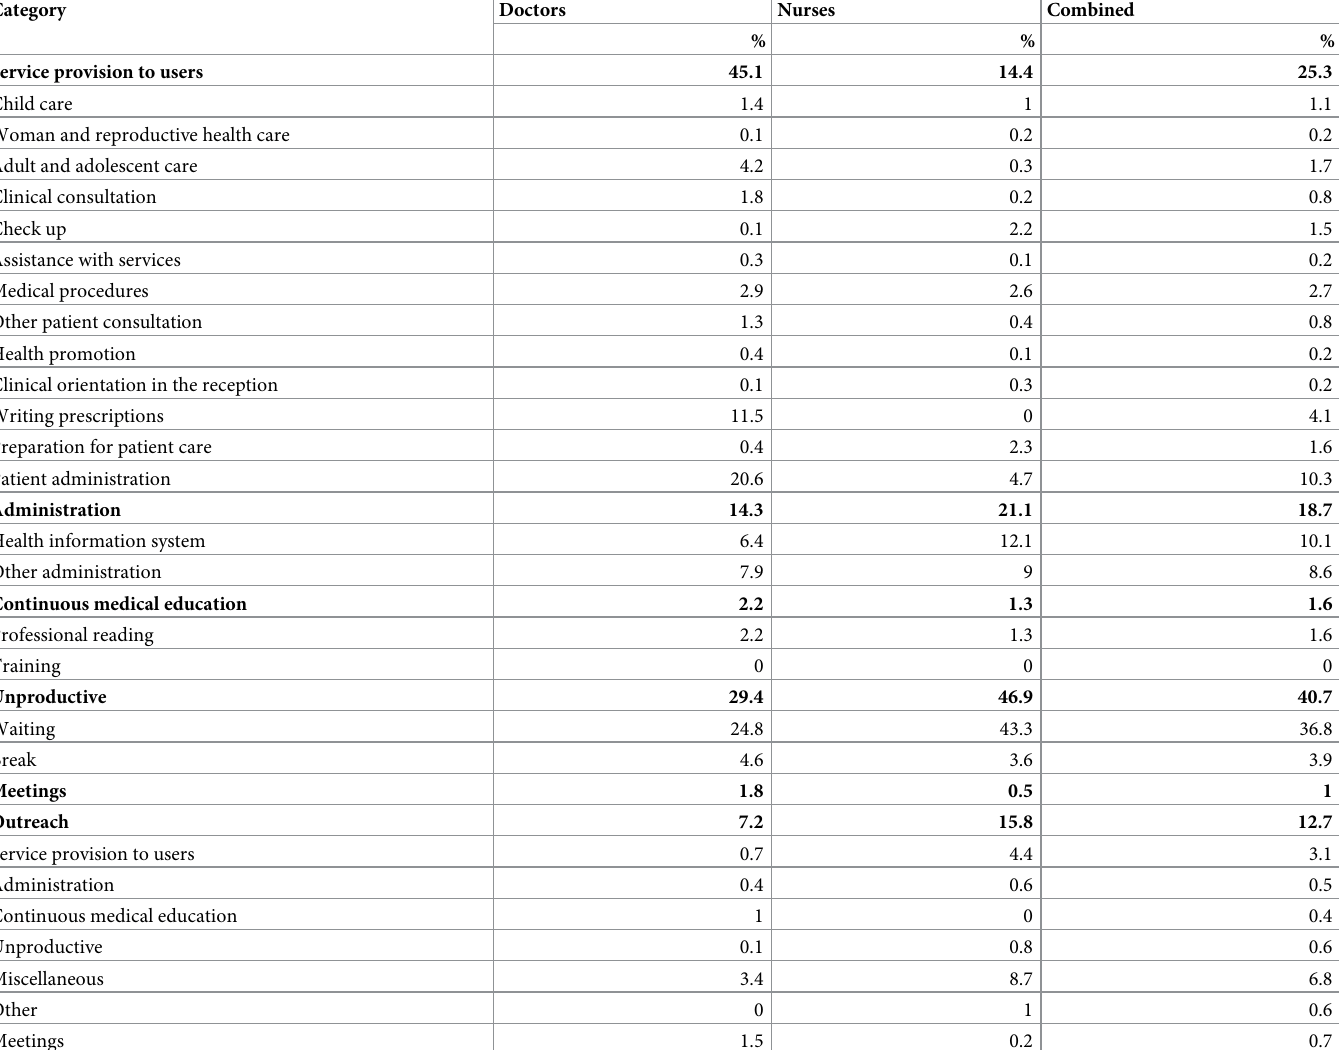
Table 2. Overall time allocation on categories and sub-categories of activities by health workers